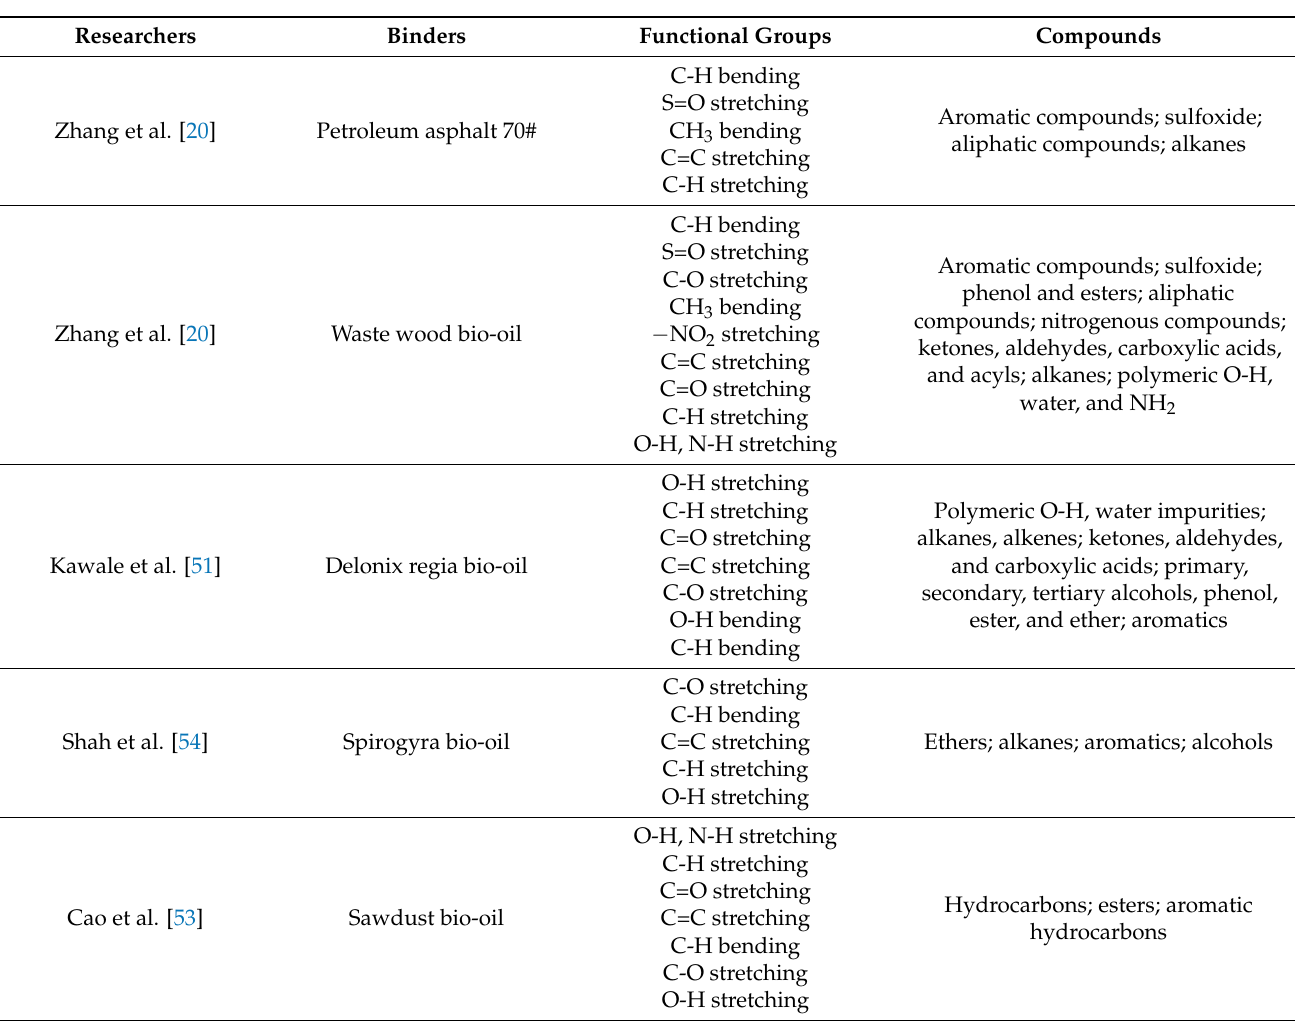
Table 3. Functional groups of bio-oils.